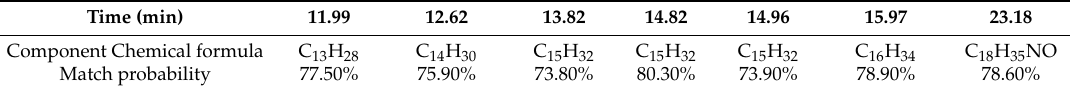
Table 2. Composition-matching statistics of water samples with oil shale heated to 500 ◦